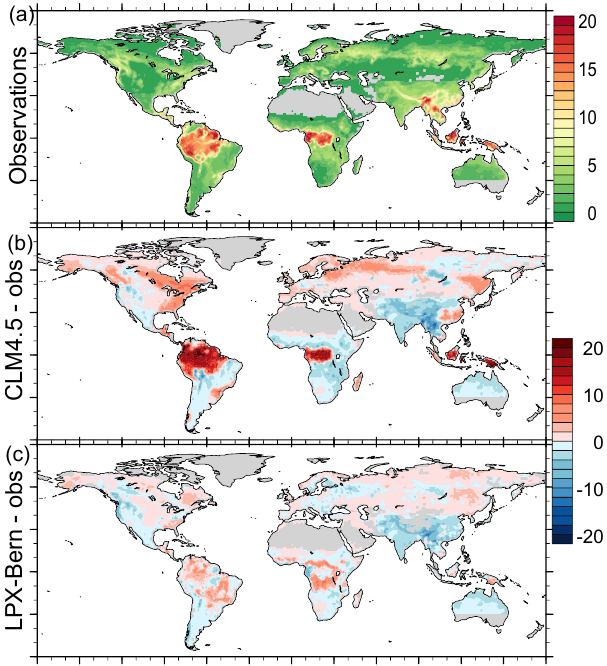
Figure 3. Estimated modern distribution of vegetation carbon de- rived from observations (Carvalhais et al., 2014) (top) and the differ- ences of model minus observation-derived distributions for CLM4.5 (middle) and LPX (bottom). All results are in kilograms of carbon per square meter (kgCm − 2 ) and averages for the decade 1996 to 2005 are used for the model